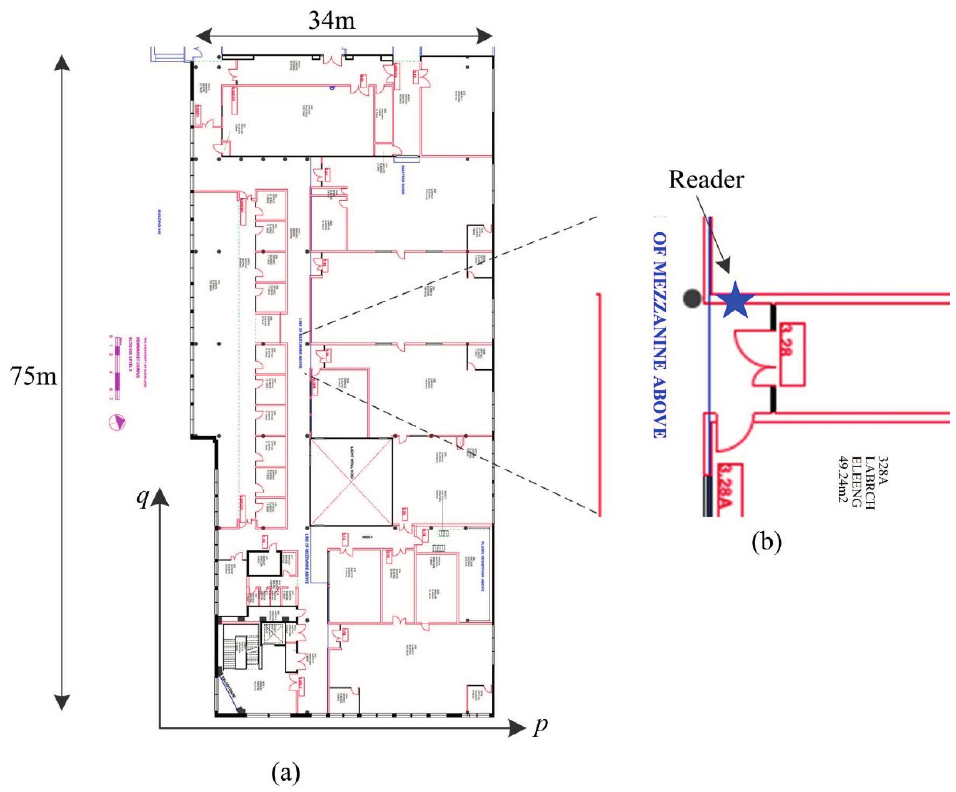
Figure 5. ( a ) Map of the test indoor environment ( b ) Example of access control